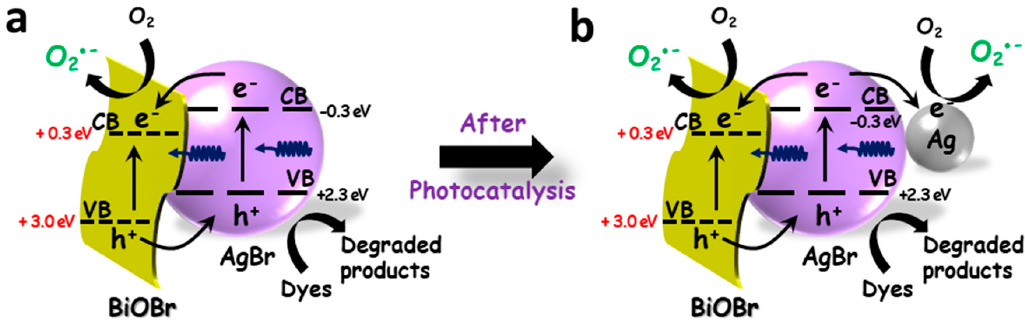
Scheme 2. Schematic diagram showing the energy band structure and charge–transfer process in the heterostructure photocatalyst before and after the